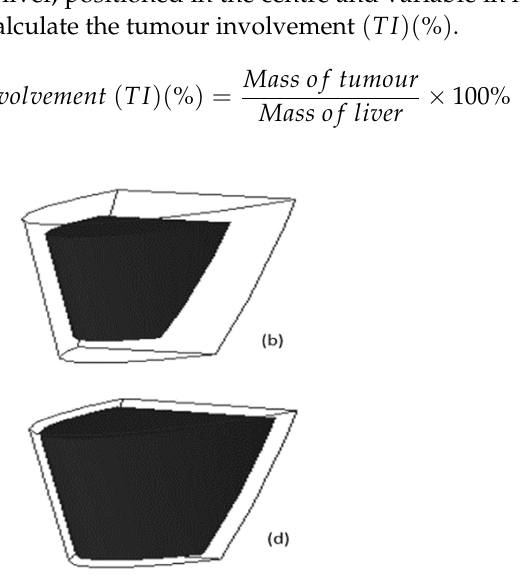
Figure 2. Antero-superior view of the tumour model for ( a ) 10, ( b ) 30, ( c ) 50, and ( d ) 70% tumour involvement (TI).